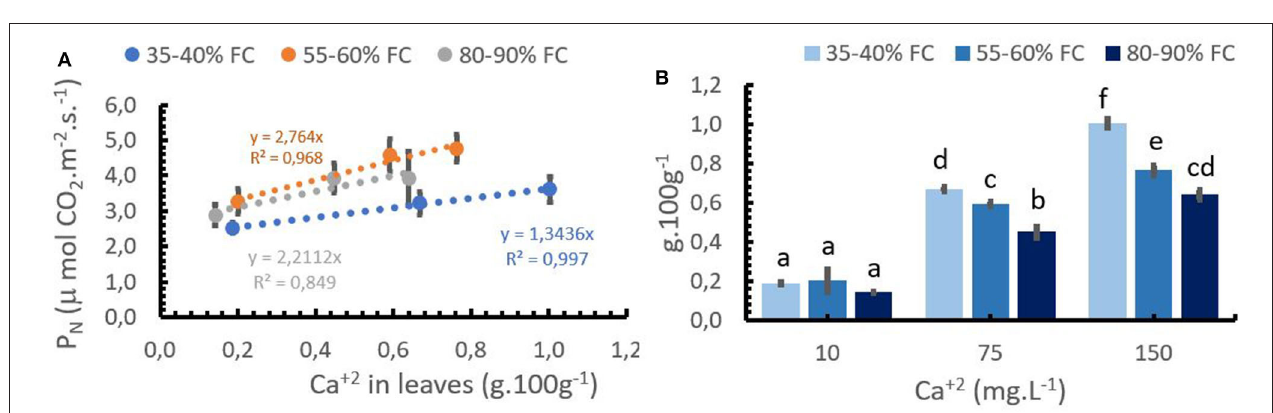
FIGURE 2 | Effect of the calcium (Ca + 2 ) rates with different water levels with respect to the field capacity (FC) on photosynthesis ( P N , A ) aboveground biomass (B) , root: shoot ratio (C) , root biomass (D) . Bars represent the mean values for each of the replicates ± standard error. Different letters represent statistically significant differences among the treatments ( P < 0.05, LSD fisher).